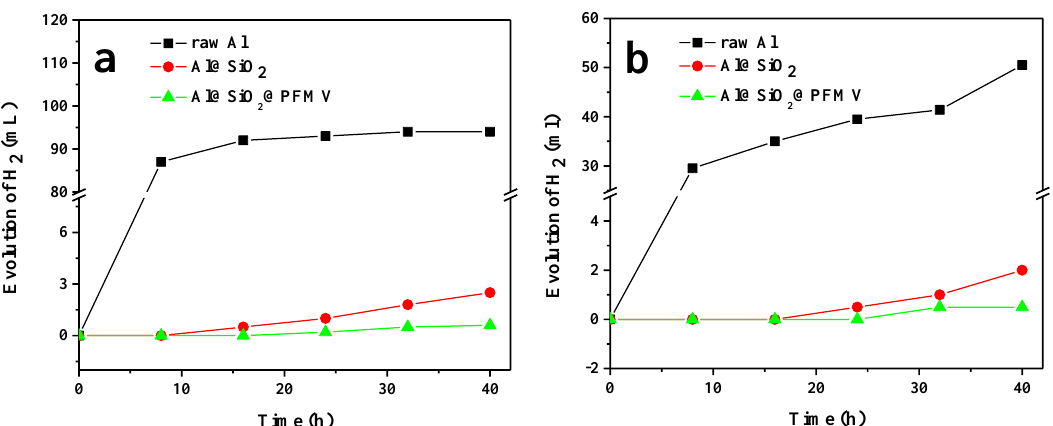
Figure 11. Corrosion resistance of raw aluminum pigments, Al@SiO 2 and Al@SiO 2 @PFMV at pH 1.0 ( a ) and at pH 12 ( b ).